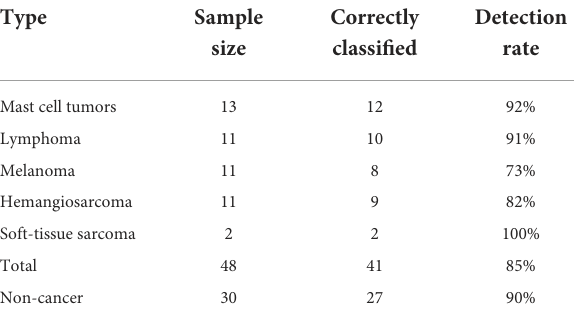
TABLE 1 Data summary for each classification of cancer versus non-cancer urine